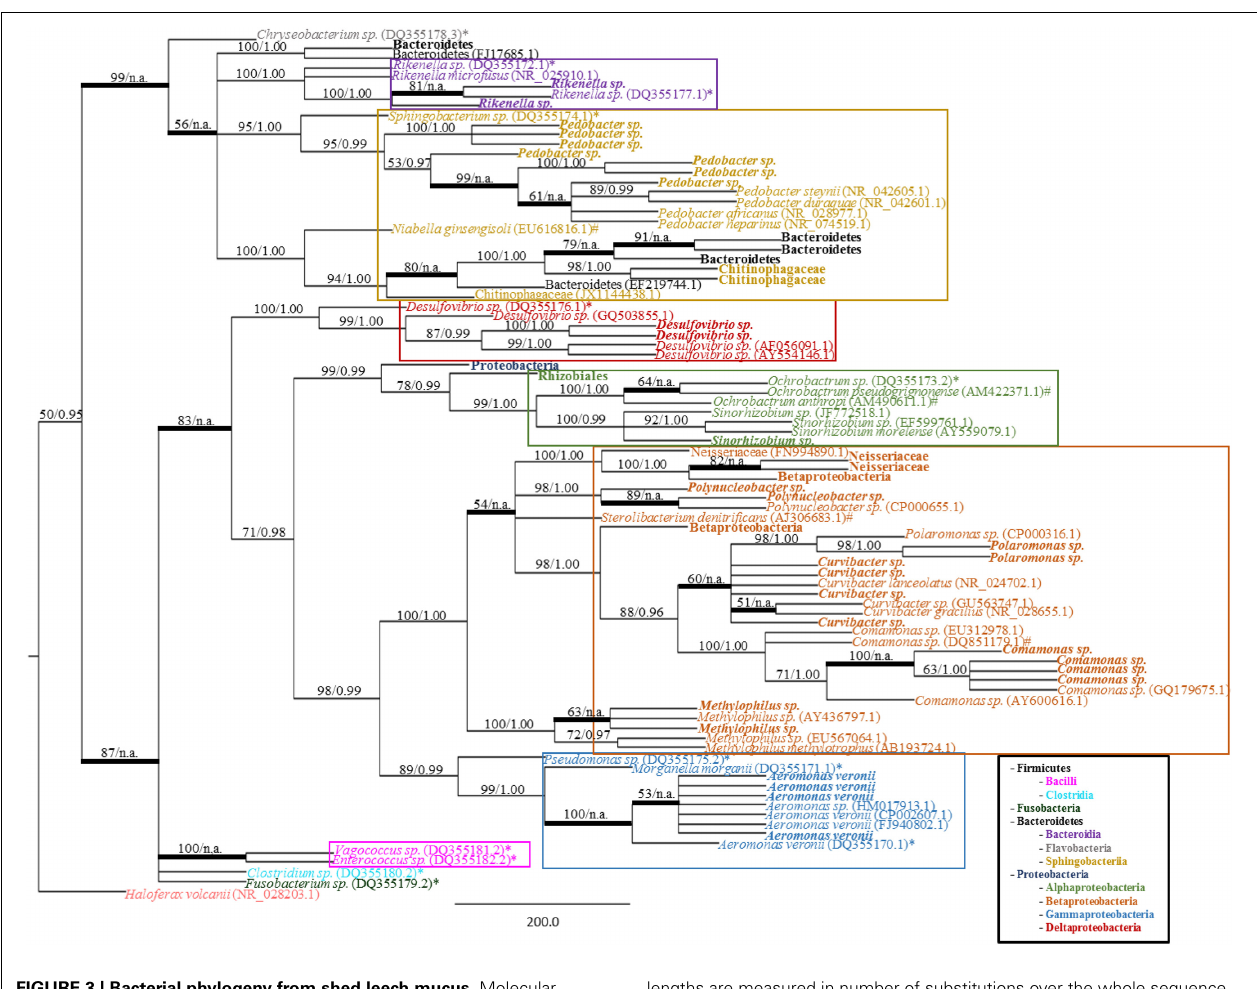
lengths are measured in number of substitutions over the whole sequence. Representative 16S rRNA sequences obtained within shed mucus are in bold, with other sequences obtained from NCBI indicated by accession numbers. Previously described leech isolates obtained through study of the gut and bladder systems are indicated by an ∗ (Worthen et al., 2006) or # (Kikuchi et al., 2009), respectively. Color blocks indicate the Class housing the representative